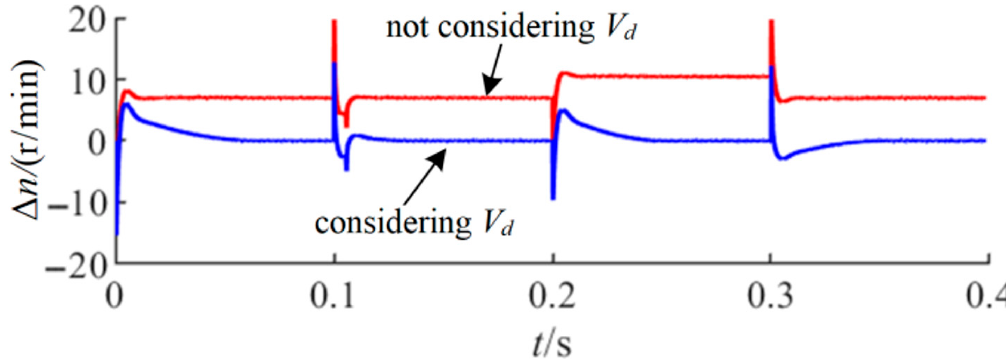
Figure 5. Simulation curve of the speed error.